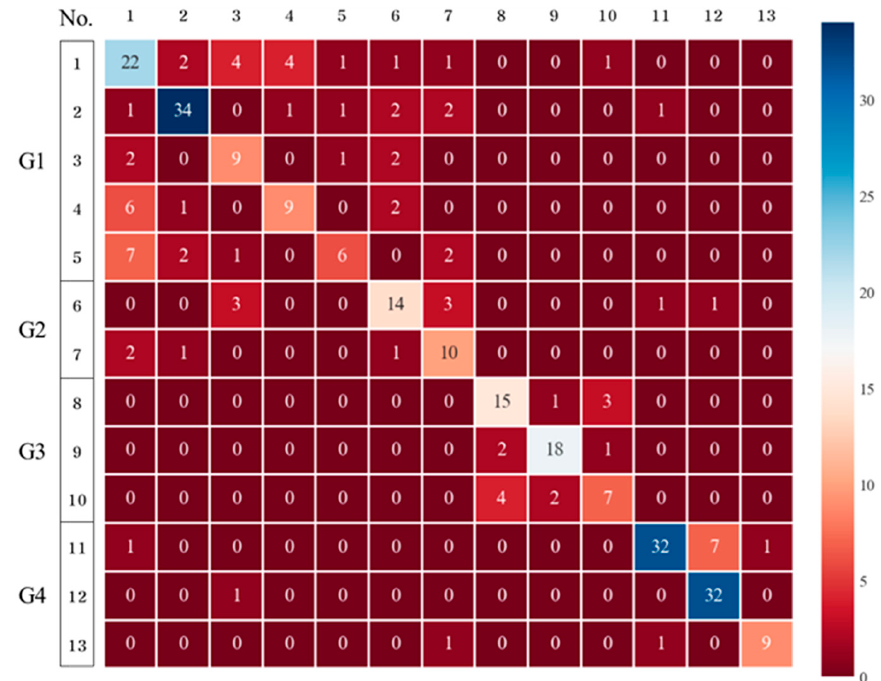
Figure 5. Confusion matrix (classification of the 13 chemicals using random forest).